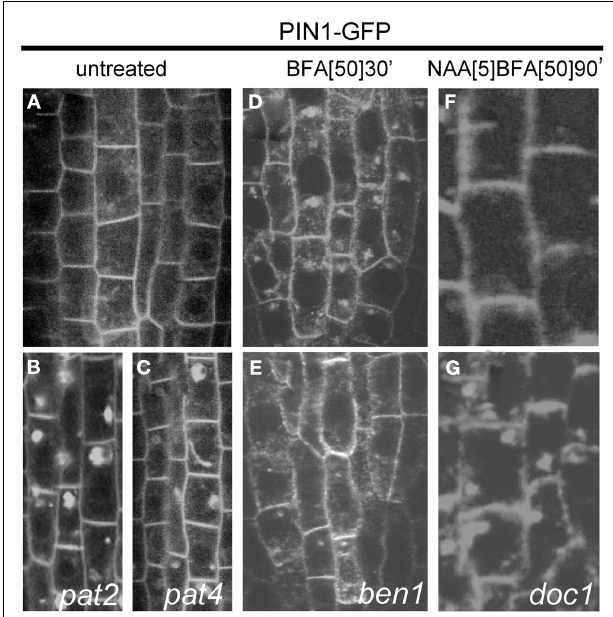
FIGURE 3 | Cellular phenotype of the mutants selected in the screens performed on PIN1–GFP mutagenized population. Plasma membrane, polar localization of PIN1–GFP protein (A) in the steel of Arabidopsis root cells.The mutants pat2 (B) and pat4 (C) displaying ectopic accumulation of PIN1–GFP marker. Adapted from Feraru et al. (2010) and Zwiewka et al. (2011).Wild type line (D) accumulating PIN1–GFP in the BFA compartments. Root cells of ben1 mutant (E) showing smaller BFA-induced internalization. Adapted fromTanaka et al. (2009). In wild type line (F) synthetic auxin NAA blocks PIN1 internalization. doc1 mutant (G) shows resistance to the inhibitory effect of auxin on the endocytosis of PIN1. Adapted from Paciorek et al.